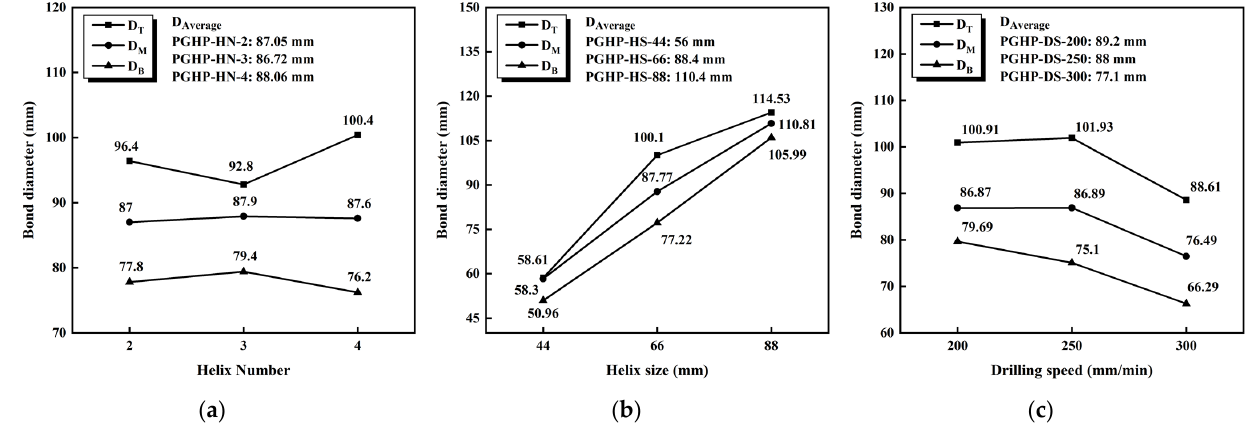
Figure 10. The small-scale pressure-grouted helical pile dimensions of the compression test, ( a ) helix number test sets, ( b ) helix size test sets, and ( c ) drilling speed test